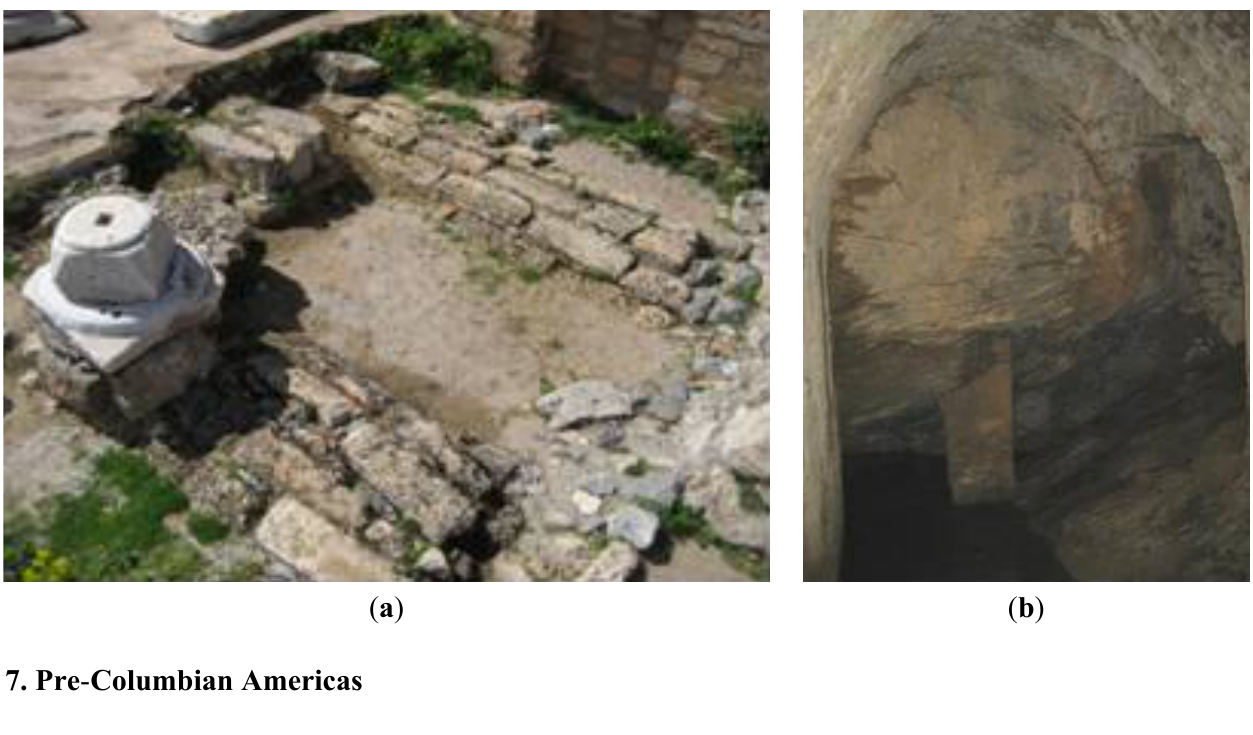
Figure 19. Cisterns of the Venetian period: ( a ) Double-domed cistern at Aghia Sofia at the upper town of Monemvasia and ( b ) Chora on Amorgos, the so-called Kato Lakkos (with permission of G.